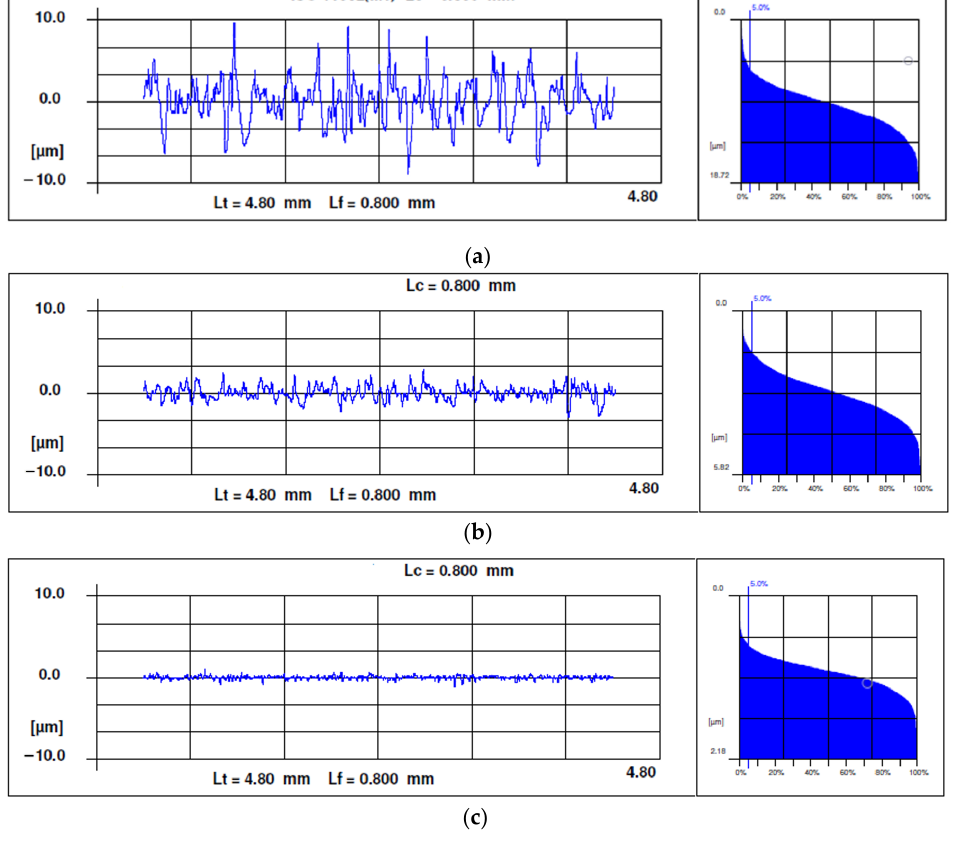
Figure 7. Examples of roughness profiles and Abbott–Firestone curves: ( a ) rough honing with grain size 181, ( b ) semi-finish honing with grain size 76 and ( c ) finish honing with grain size 30.